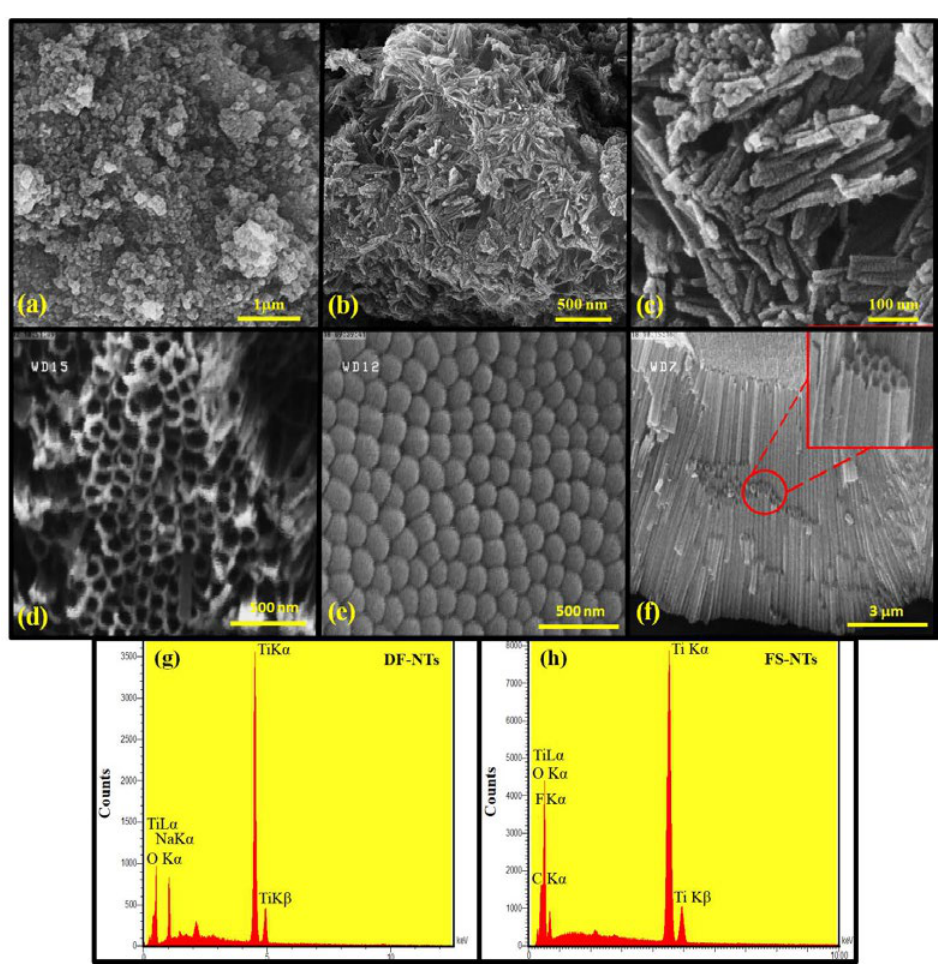
Fig. 2. FESEM images corresponding to (a) P25, (b,c) DF-NTs and (d-f) FS-NTs; and the EDS spectrum of (g) DF-NTs and (h)